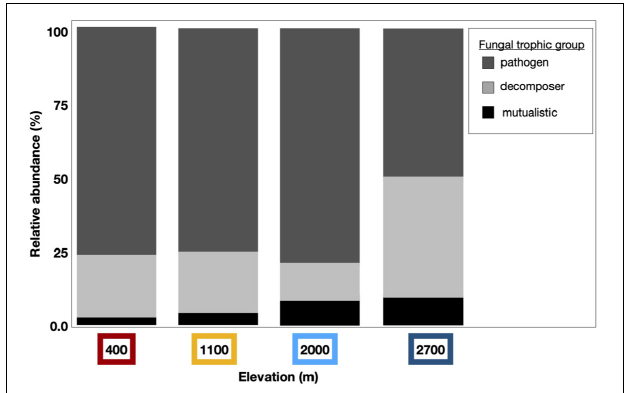
FIGURE 6 | Dust fungal ITS1 trophic groups vary by elevation. Dust-associated fungal OTUs were assigned to functional groups using the online application FUNGuild; Those fungal taxa with high confidence levels were curated and binned by trophic group to pathogens (dark gray), decomposers (light gray), or mutualistic fungi (black). Bar graphs represent the relative abundance of these trophic groups within assigned fungal taxa from each elevation. The relative abundance of mutualistic fungal taxa increased clinally by elevation and more fungal pathogens were found at lower elevations than at the highest elevation